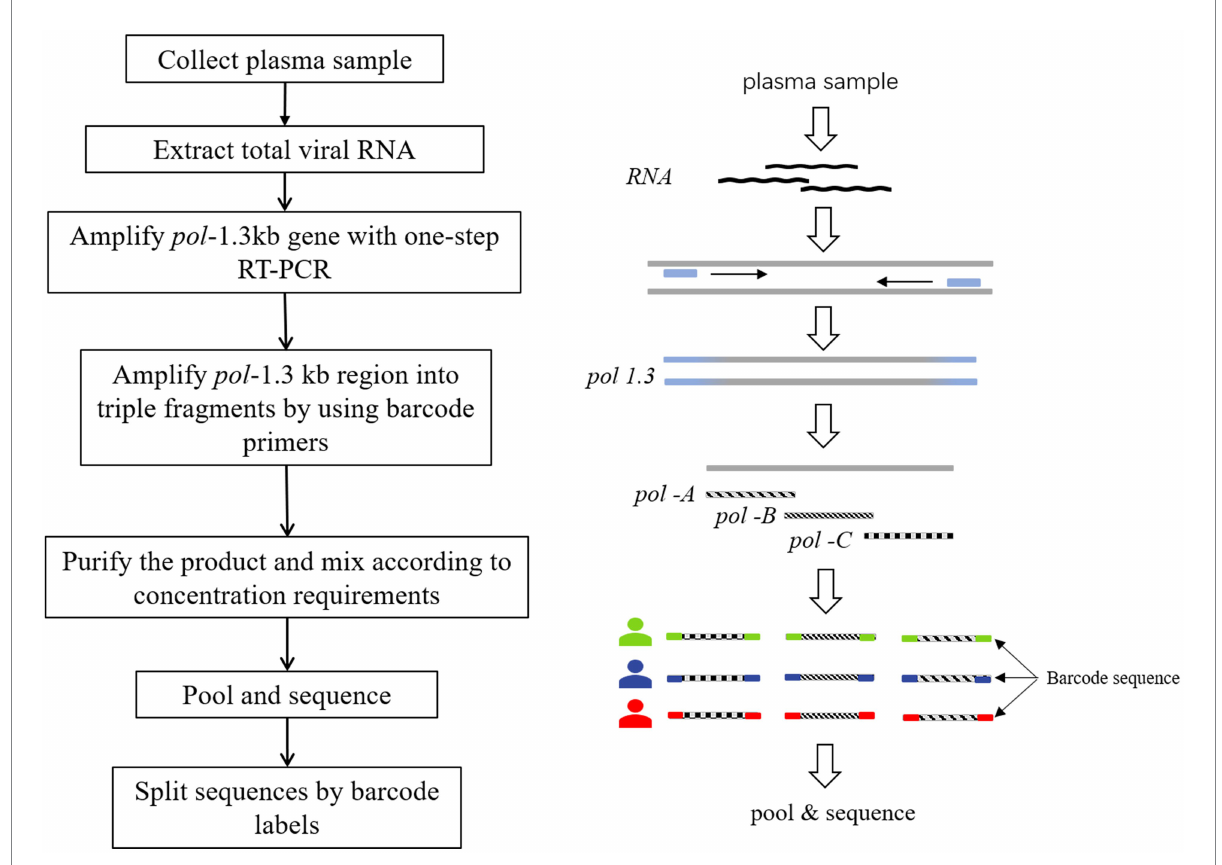
FIGURE 1 Tagged-amplicon deep sequencing strategy. HIV-1 pol -1.3kb gene was amplified with one-step RT-PCR. Subsequently, nested PCR was used to amplify pol-1.3kb region into 3 fragments, labeled as pol -A, pol -B, and pol -C. There was a small overlap at the junction of the three amplicons. The molecular barcode was attached to both ends of the amplicons. Barcodes were used to split data to distinguish different